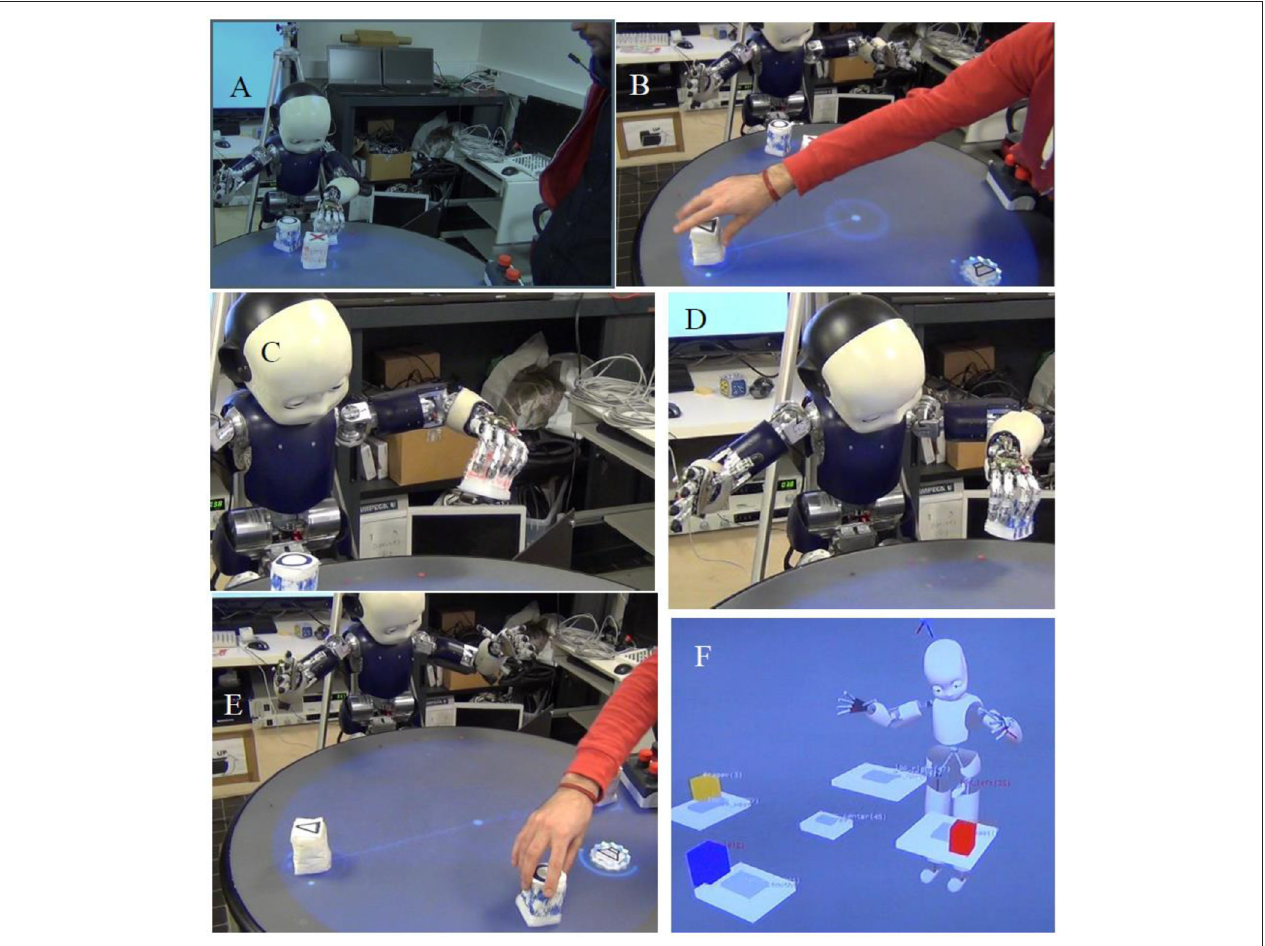
FIGURE 8 | Different steps of the iCub during the execution of a shared plan for a musical came. (A) Initial configuration of 3 elements. The robot places the object 1 (white and yellow) to the location North. (B) Human takes the object and places it on the location West. (C) The robot places the object 2 (red) to the location North, for the human, who then puts it to the location East (not displayed). (D) The robot places the object 3 (blue) to the location North. (E) The Human takes the object 3 and puts it to the location South. (F) Final internal representation of the objects on the ReacTable (a musical table) to produce the song as the joint goal of the shared plan. From Pointeau et al.